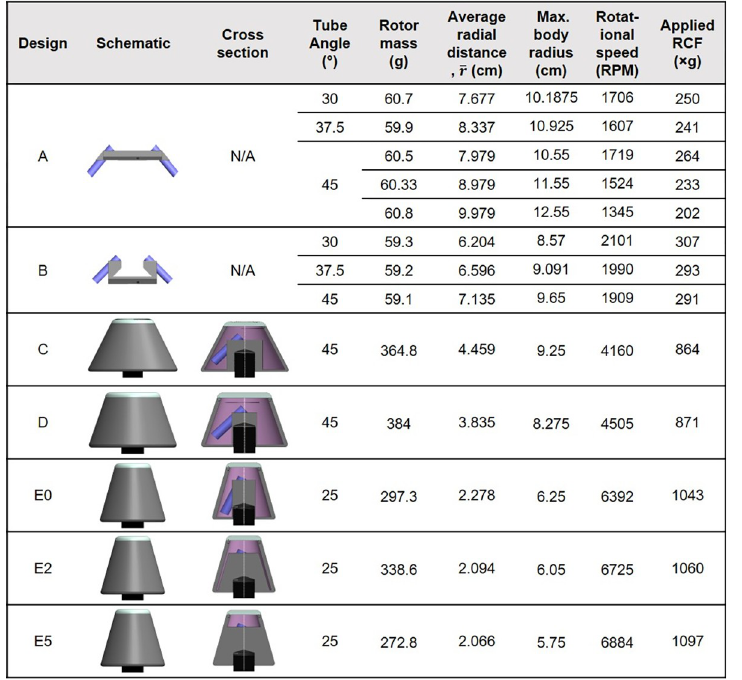
Fig 3. Evolution of design and basic